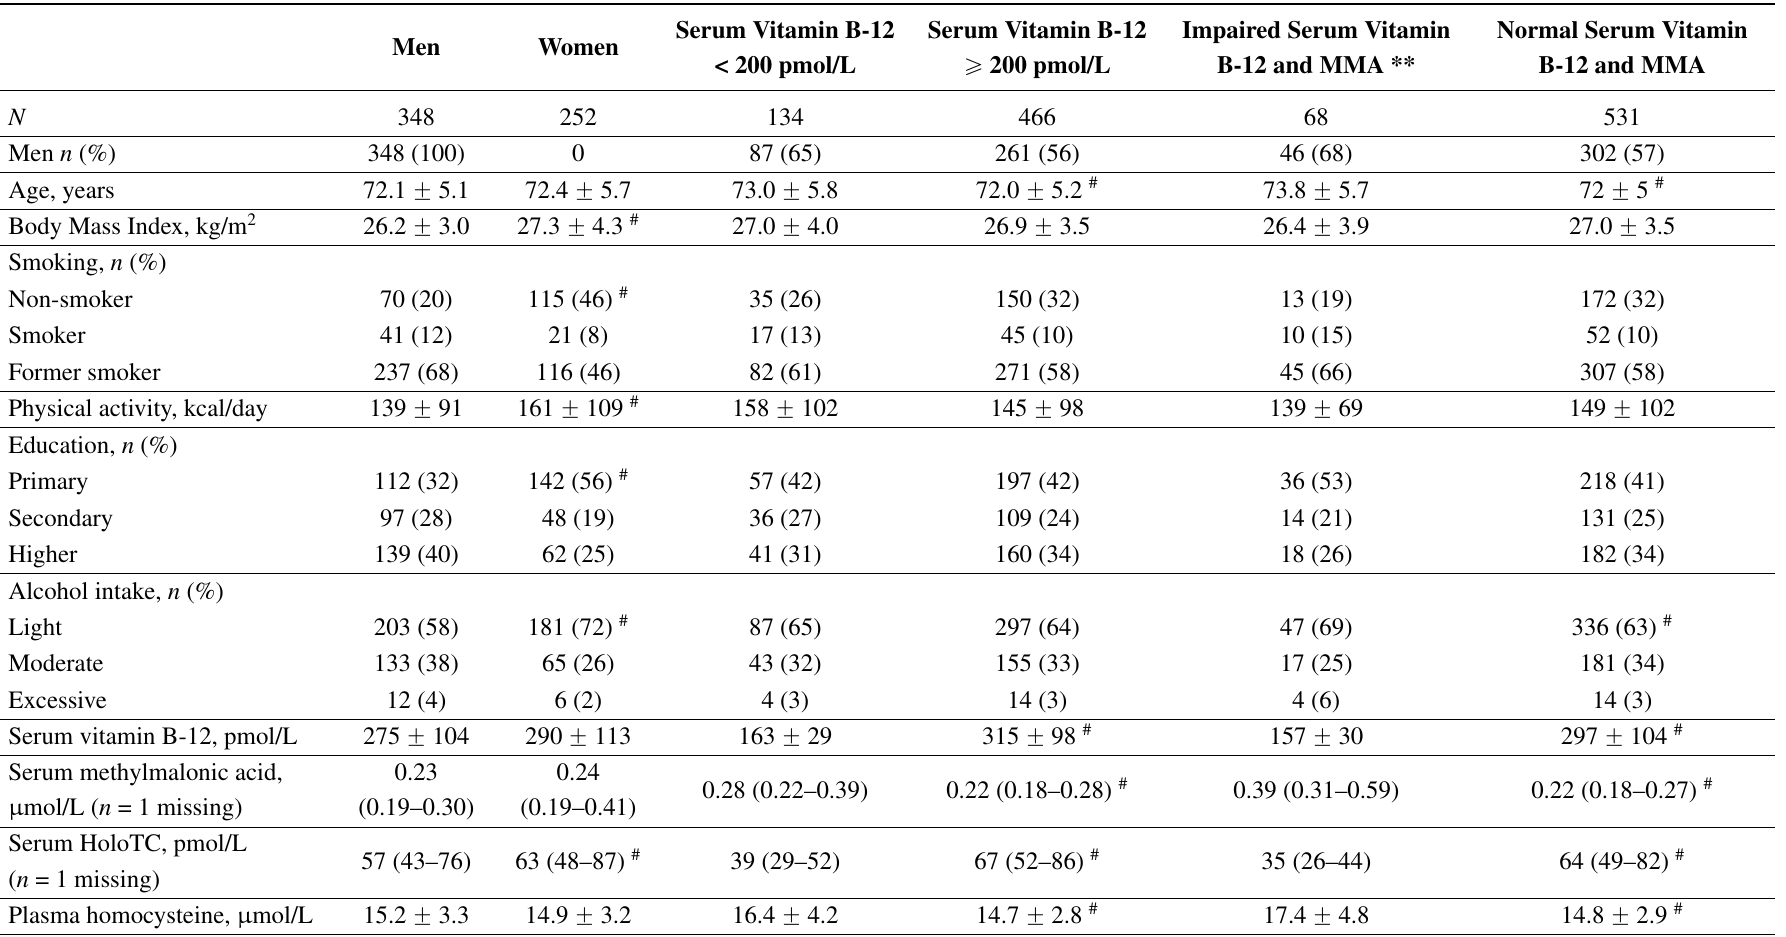
Table 1. Baseline characteristics of the participants of the B-PROOF Study ( n = 600)